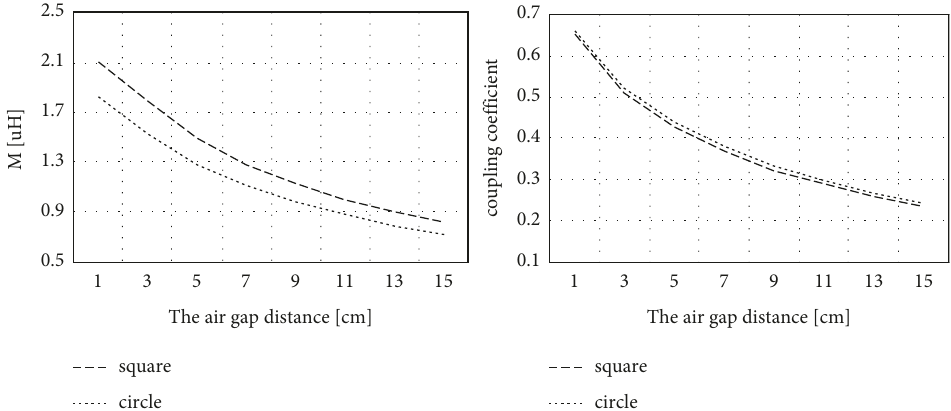
Figure 2: Mutual inductance M and coupling coefficient vary with air gap fluctuation.